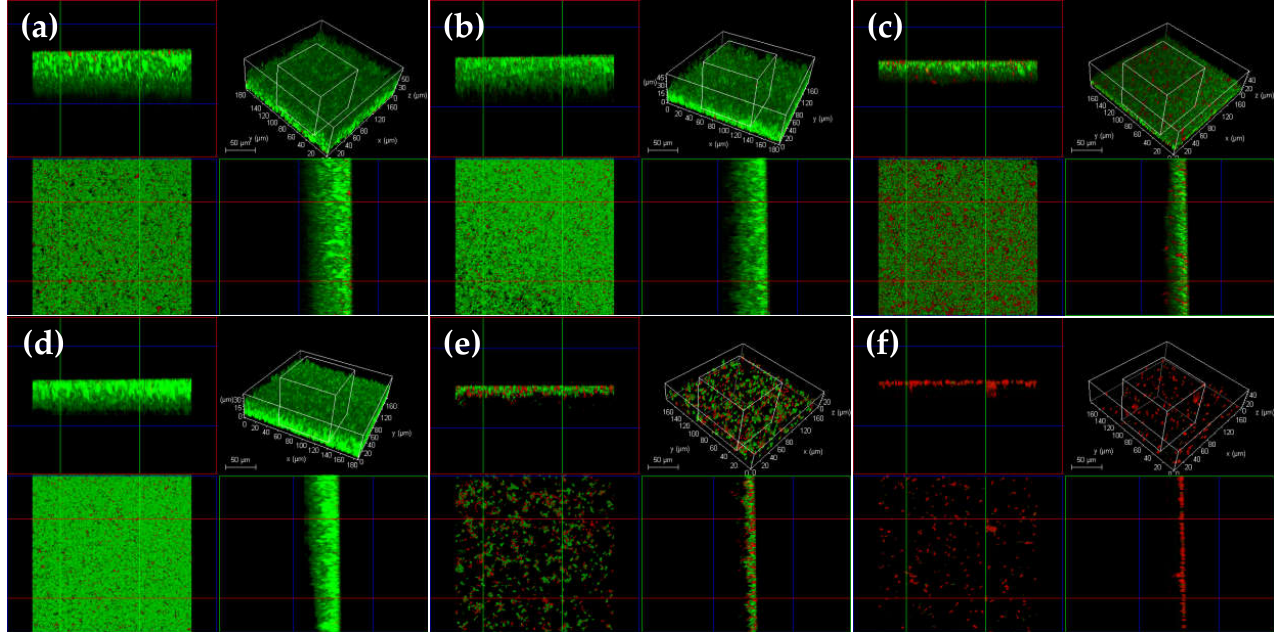
Figure 1. CLSM analysis of T. pyogenes isolate (BMH06-3) biofilm co-incubated with luteolin for 72 h (Green: live bacteria; red: killed bacteria; black: no bacteria). ( a ) Blank control biofilm. ( b ) Solvent control biofilm (1% DMSO). ( c ) Biofilm co-incubated with ceftiofur (0.25 ng/mL). ( d – f ) Biofilm co-incubated with luteolin (39, 78 and 156 µ